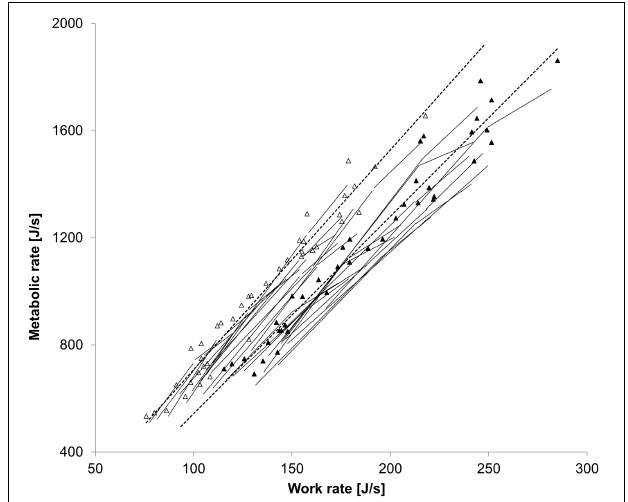
FIGURE 2 | The relationship between the work rate and metabolic rate while walking/running with ( (cid:78) ) or without ( (cid:49) ) a stroller on the 10% incline. Both individual values and average values of all participants (broken lines) are